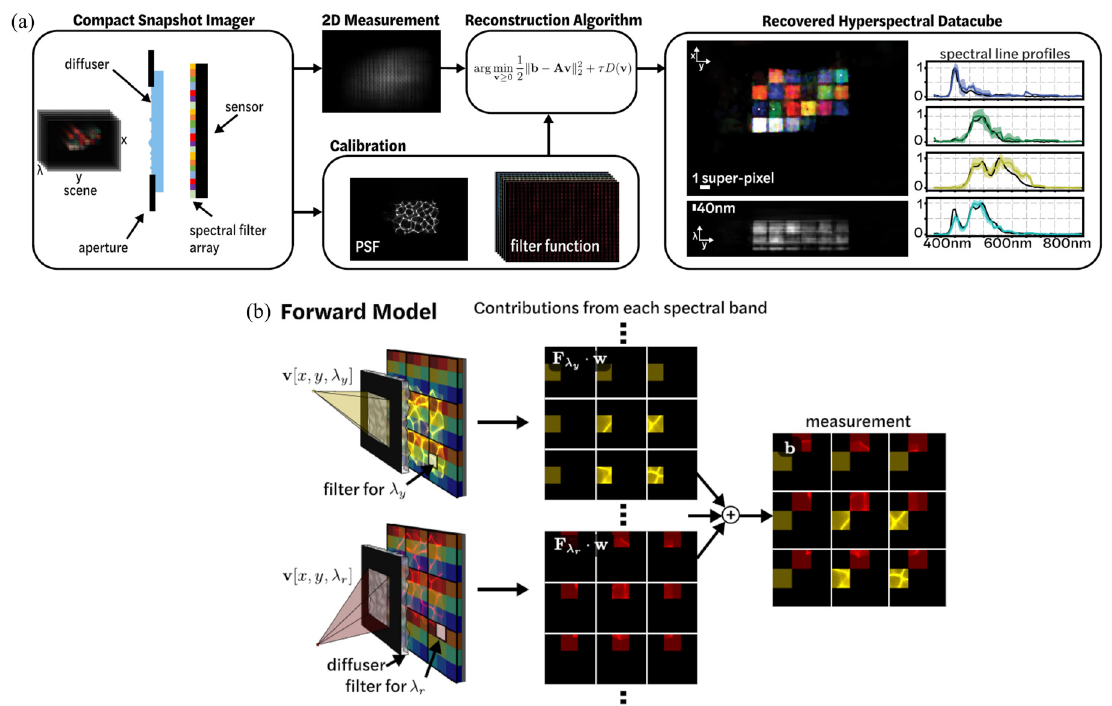
Figure 4: The working mechanism of combining a diffuser and spectral filter array to improve the spatial resolution in spectral imaging. (a)Overviewof theSpectralDiffuserCamimagingpipeline,whichreconstructsa hyperspectral data cube froma single-shot 2D measurement. (b) Image formation model for a scene with two point sources of different colors, each with narrow-band irradiance centered at y (yellow) and r(red).The fi nalmeasurementisthesumofthecontributionsfromeachindividualspectral fi lterbandinthearray.(a)and(b)arereprintedwith permission from Ref. [28], copyright 2019 Optical Society of